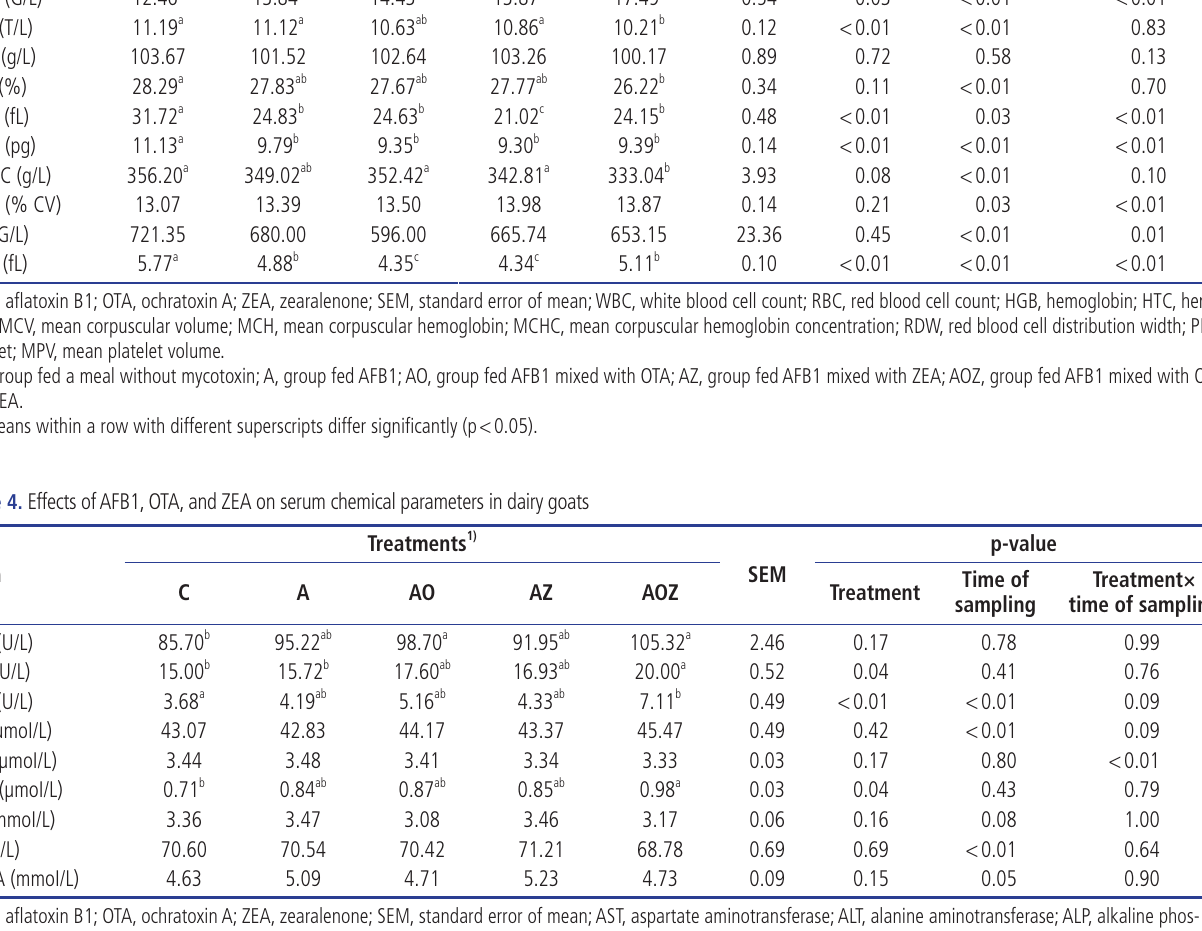
Table 3. Effects of AFB1, OTA, and ZEA on hematological parameters in dairy goats Item